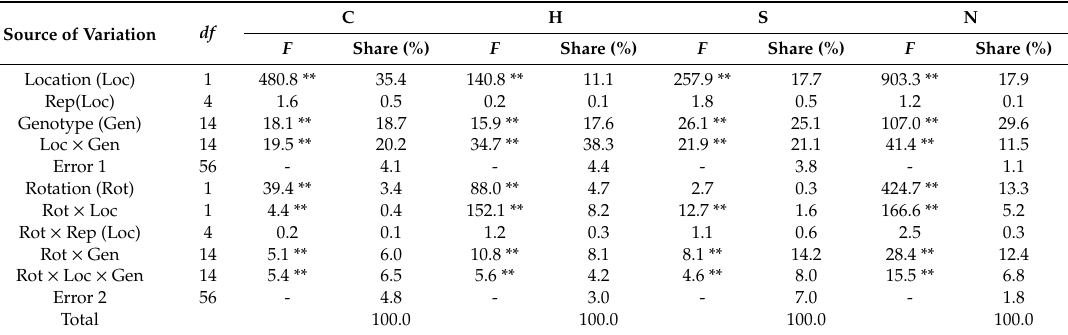
Table 2. Statistics F from the repeated measure variation analysis and the percentage share of e ff ects in the total variation for the elemental composition of willow